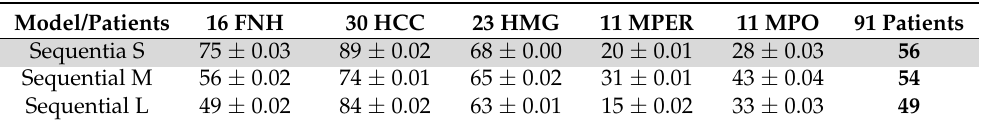
Table 5. Average test accuracy [%] and the corresponding standard deviation. Unbalanced number of examples per class.